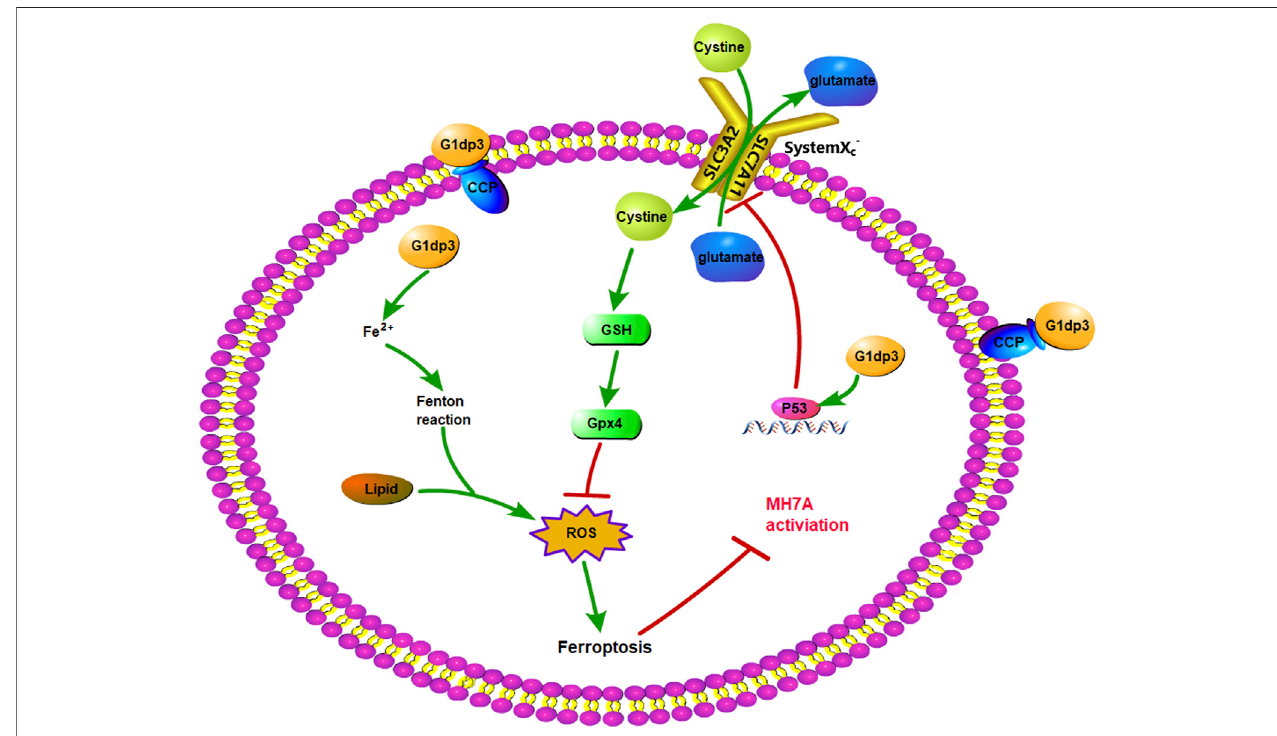
FIGURE 5 | p53/SLC7A11 pathways play an essential role in G1dP3-regulated MH7A ferroptosis. G1dP3 treatment induced p53 overexpression, SLC7A11 inactivation, GSH depletion, Gpx4 de fi ciency, ROS production, ferroptosis activation, and ultimately suppressed MH7A cell activation.